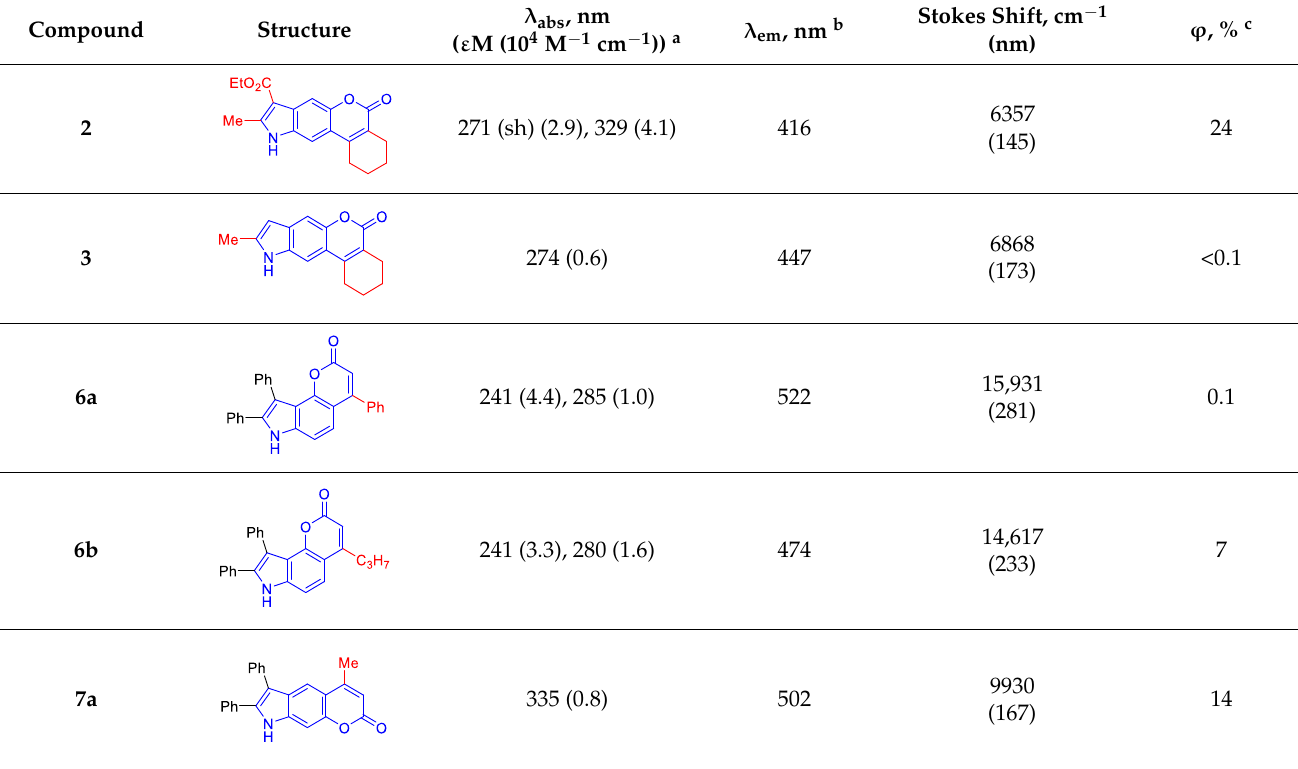
Table 1. Experimental photophysical data of the pyranoindole compounds and their structural motifs in acetonitrile at room temperature.